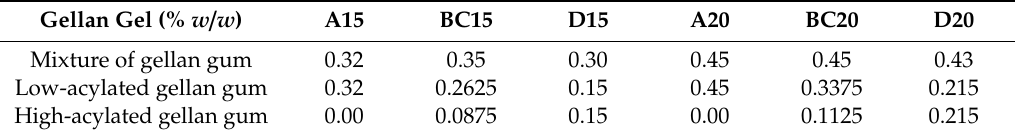
Table 1. Formulation of gellan gels used as model soft foods.